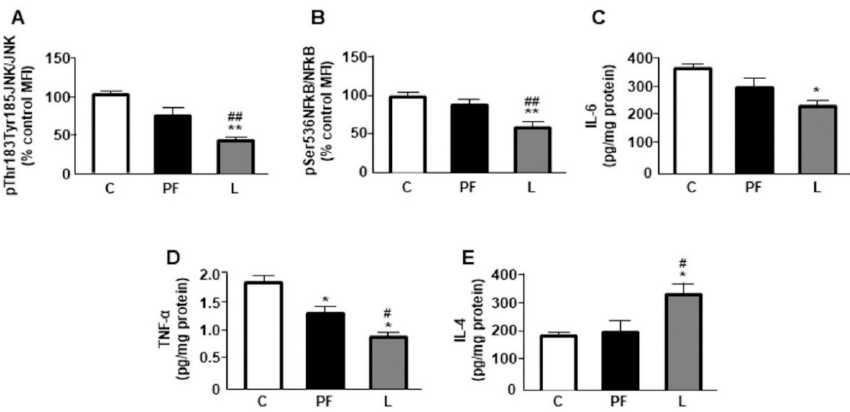
Figure 4. Effect of chronic central leptin treatment on inflammatory markers in brown adipose tissue (BAT). ( A ) Relative protein levels of c-Jun N-terminal kinase (JNK) phosphorylated (p) at Thr183/Tyr185 (pThr183/Tyr185JNK), and ( B ) nuclear factor kappa B (NFkB) phosphorylated at Ser536 (pSer536NFkB), and ( C ) interleukin (IL)6, ( D ) tumor necrosis factor (TNF) α and ( E ) IL-4 content in the interscapular BAT of control rats (C), pair-fed rats (PF) and rats receiving a chronic icv leptin infusion (L). Data are presented as means ± SEM. N = 5. MFI, median fluorescent intensity. * p < 0.05, ** p < 0.01 vs. C; # p < 0.05, ## p < 0.01 vs. PF.